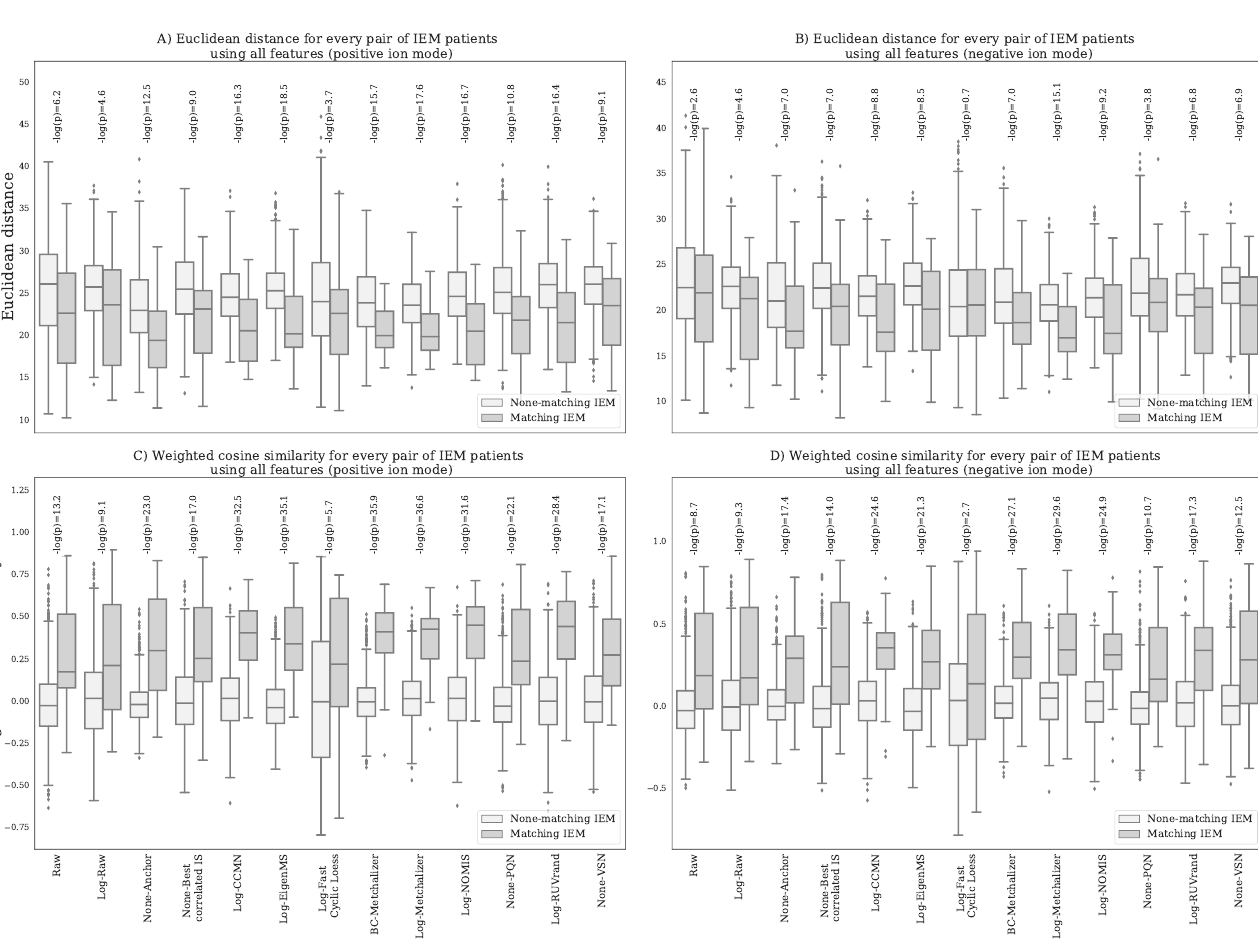
Figure A9. Given a certain normalization method, each boxplot shows the Euclidean distance / weighted cosine similarity for pairs of patients, either sharing or not sharing the same IEM as indicated by the legend. We used the Mann-Whitney U test to test how these two groups differed from each other, and showed the -log( p -value) above each corresponding method. ( A ) Euclidean distances for positive ion mode ( B ) Euclidean distances for negative ion mode. ( C ) Weighted cosine similarities for positive ion mode. ( D ) Weighted cosine similarities for negative ion